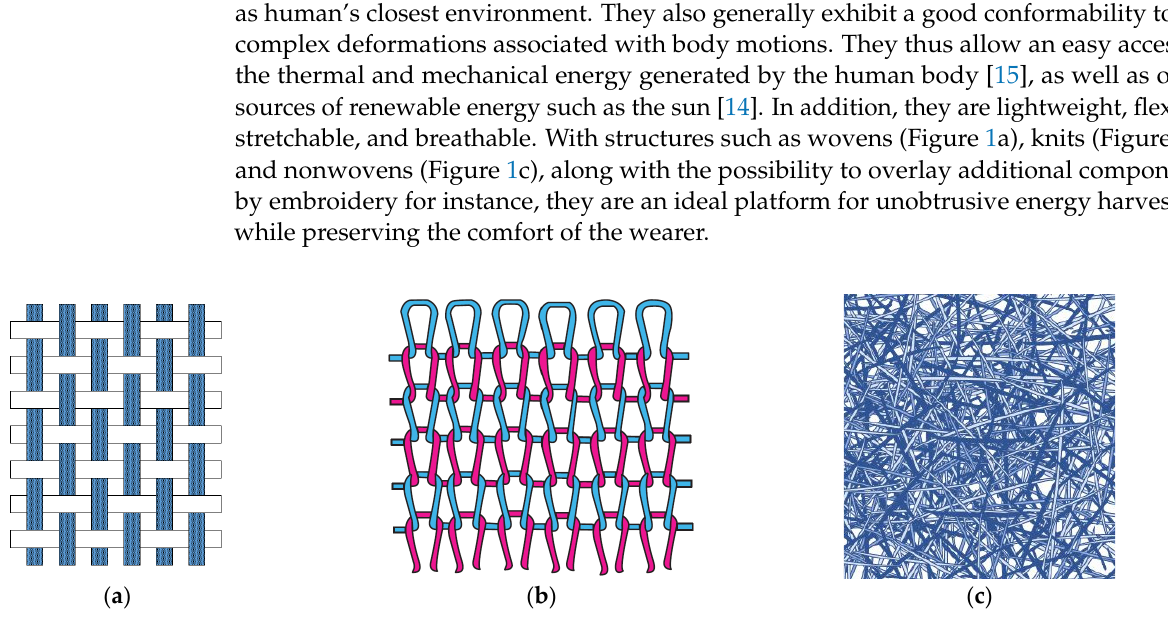
Figure 1. Examples of textile structures relevant to energy harvesting devices: ( a ) woven; ( b ) knit; ( c ) nonwoven mat (source: Md. Rashedul Islam, with permission).